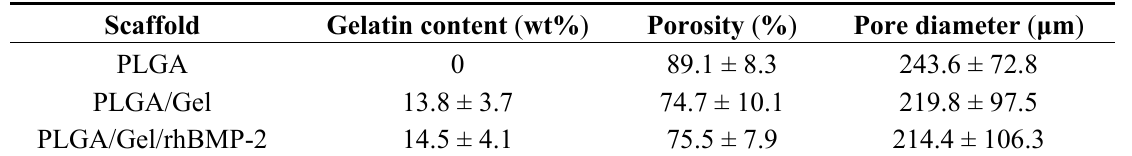
Table 1. Physical properties of scaffolds.